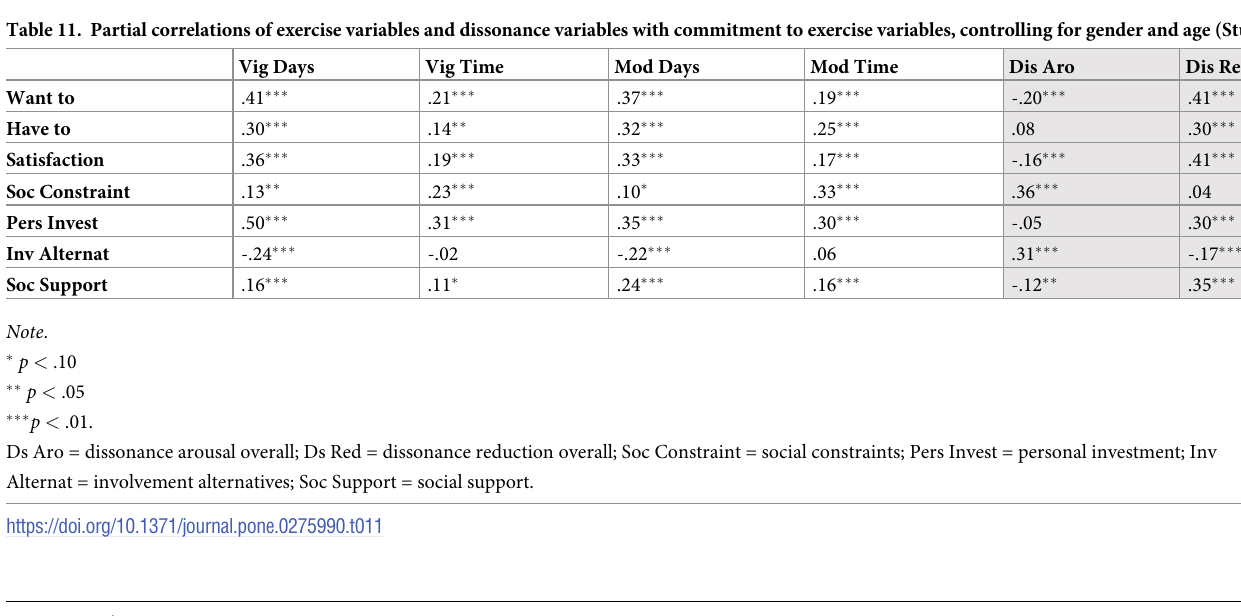
Table 11. Partial correlations of exercise variables and dissonance variables with commitment to exercise variables, controlling for gender and age (Study 2). Vig Days Vig Time Mod Days Mod Time Dis Red Want to .41 ��� Have to .30 ���